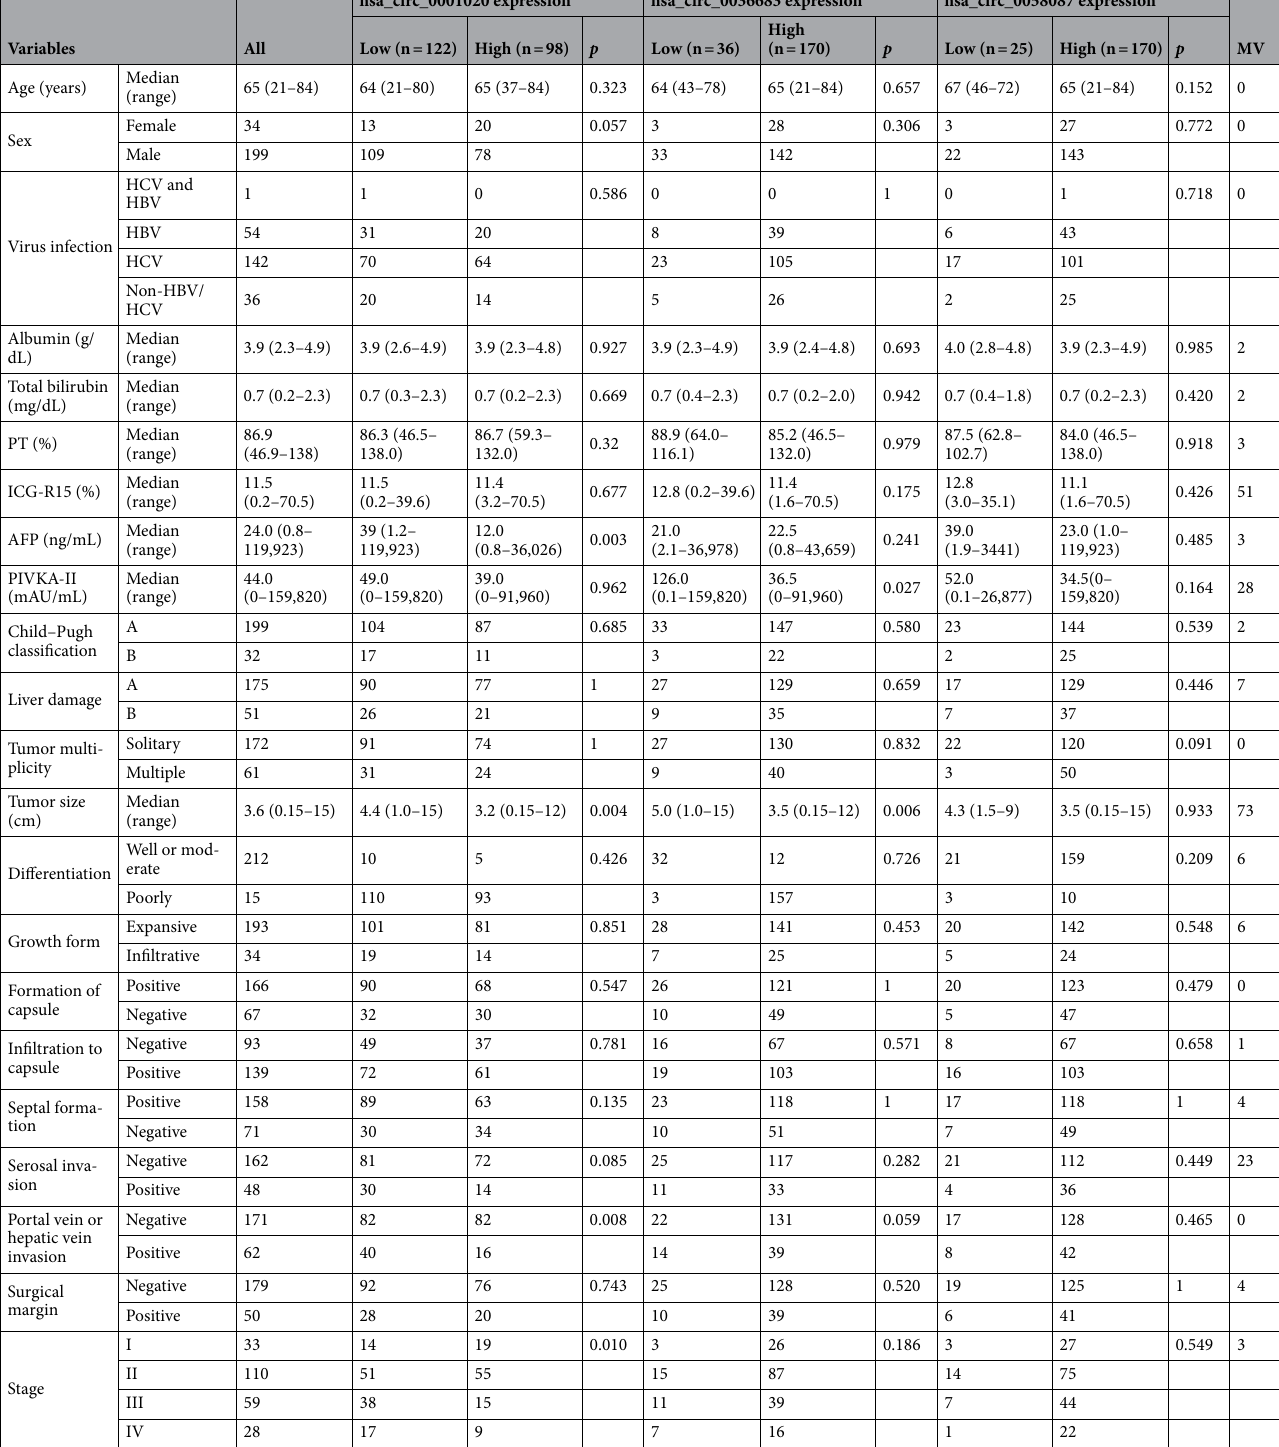
Table 1. Clinical features stratified by hsa_circ_0001020, hsa_circ_0036683 and hsa_circ_0058087 expression. n number, HBV hepatitis B virus, HCV hepatitis C virus, PT prothrombin time, ICG-R15 retention rate